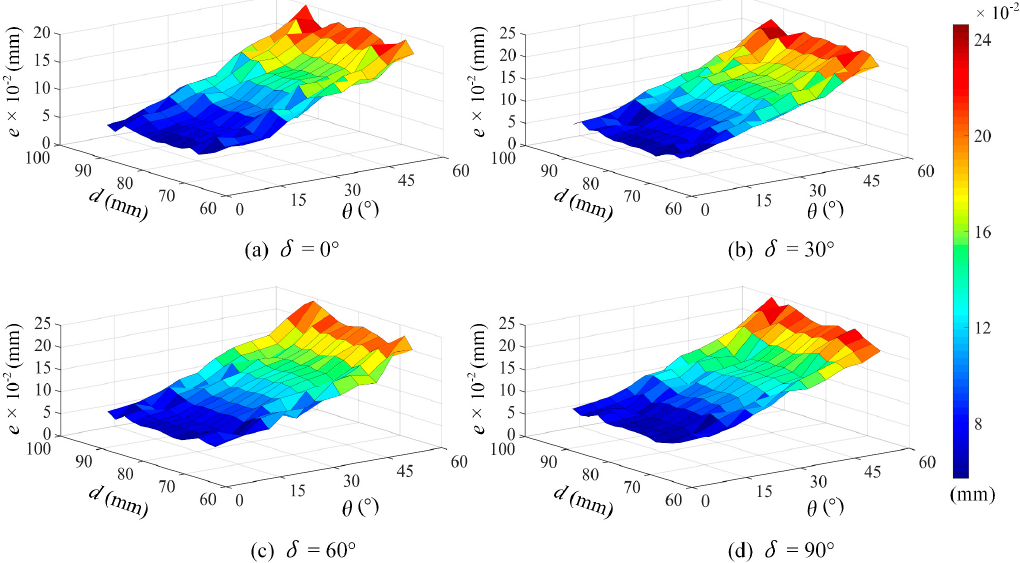
Figure 6. Evaluation results on the inclined model: ( a – d ) show the error maps obtained under the conditions of azimuth angle δ = 0 ◦ , δ = 30 ◦ , δ = 60 ◦ , δ = 90 ◦ , respectively.